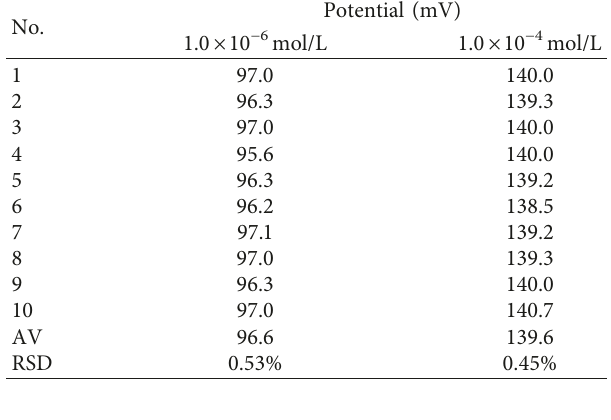
Table 2: Reproducibility of the GPE/COF